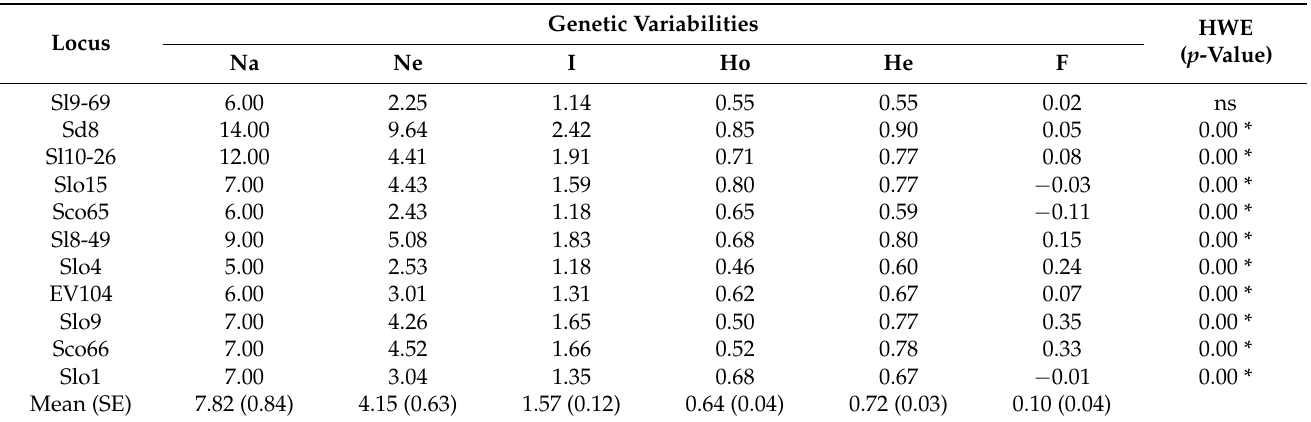
Table 1. The observed number of alleles (Na), effective number of alleles (Ne), Shannon’s information index (I), observed heterozygosity (Ho), expected heterozygosity (He), Fixation Index (F), and Hardy– Weinberg Equilibrium (HWE) p -values across 16 microsatellite primers.